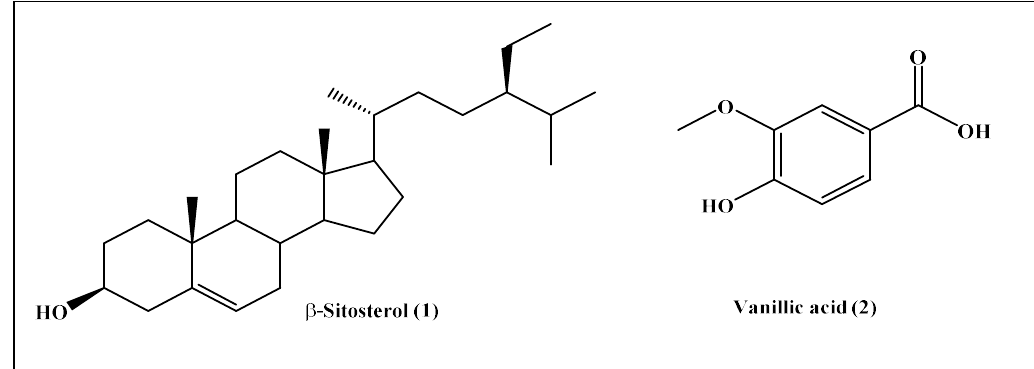
Figure 1. Compounds isolated from D. bupleuroides chloroform and ethyl acetate